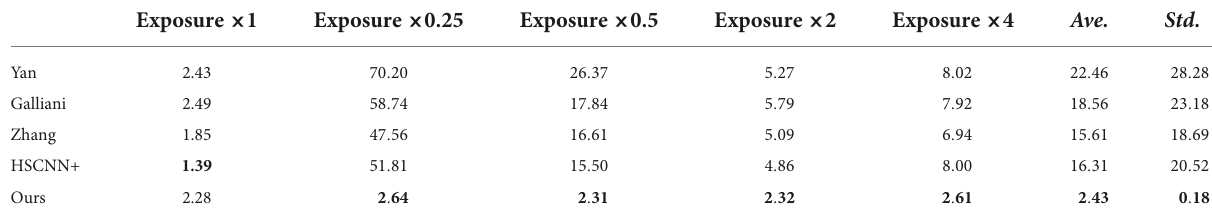
TABLE 2 Comparison of the mean relative absolute error (MRAE) (%) of different methods under different tested exposure levels. Exposure × 1 Exposure × 0.25 Exposure × 0.5 Ave.